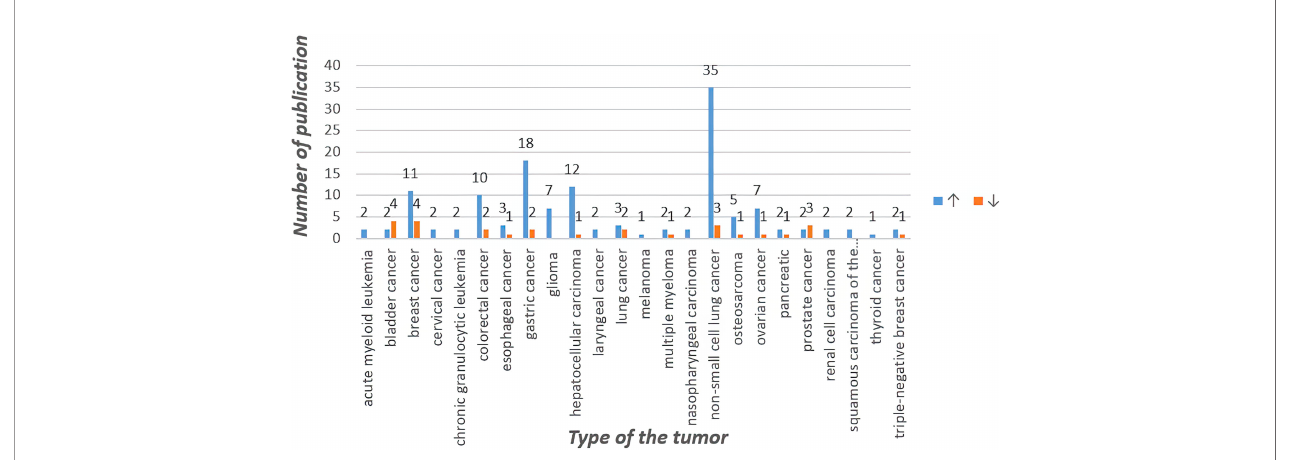
FIGURE 1 | Statistics of circRNA related to chemotherapy resistance in different tumors in recent fi ve